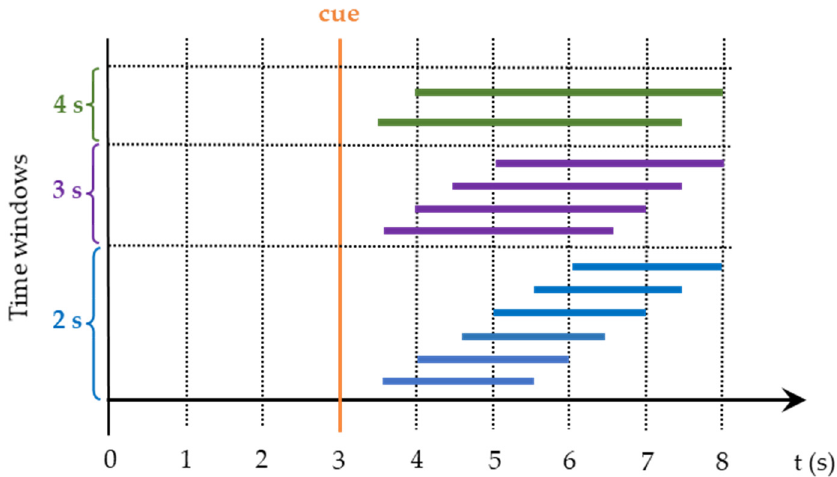
Figure 5. To calculate CSP filters and classifiers different time window–length segments were se- lected.